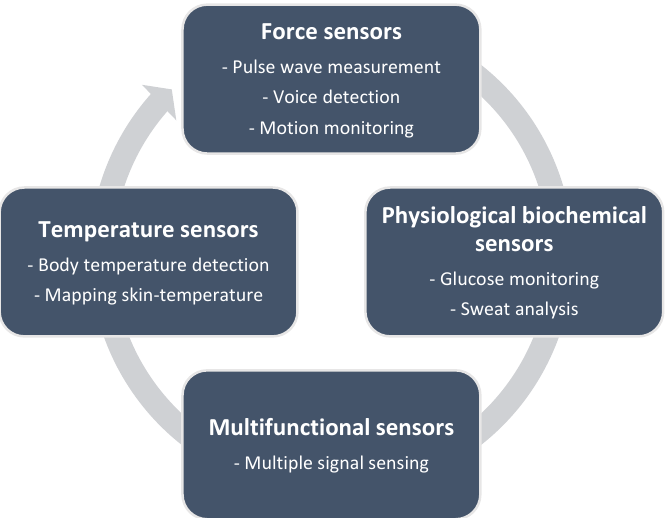
Figure 5. Recent developments in wearable electronics for monitoring human health information.